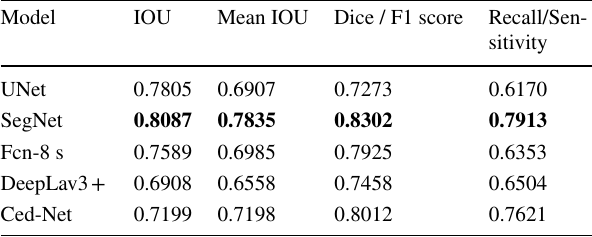
Table 3 The results of CNN models tableModel Bold represents the highest values obtained and to facilitate their knowledge by looking at the